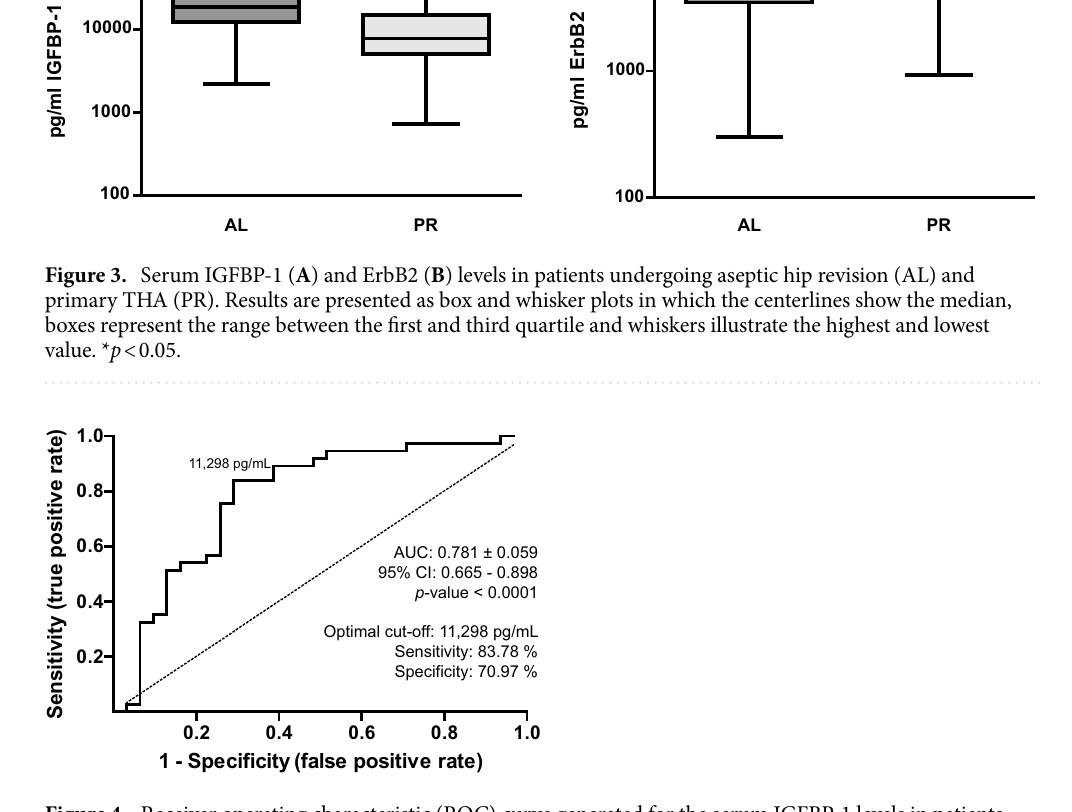
Figure 4. Receiver operating characteristic (ROC) curve generated for the serum IGFBP-1 levels in patients undergoing aseptic hip revision (AL) and primary THA (PR). The area under the curve (AUC) is expressed as mean ± standard error including the 95% confidence intervals (CIs). The dashed diagonal line represents the line of identity or no discrimination. The optimal cut-off value (indicated in the graph) and the associated data for sensitivity and specificity are